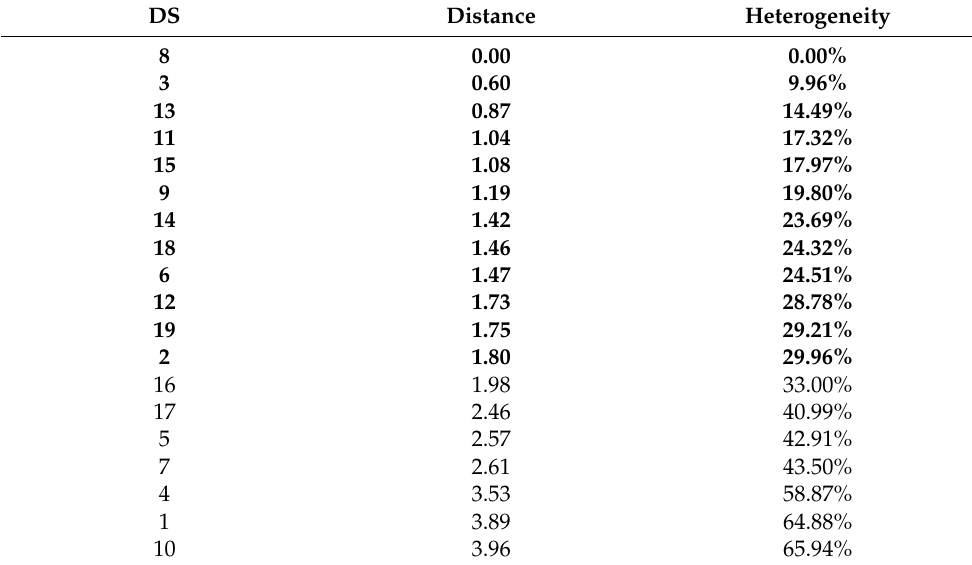
Table 6. Distance and heterogeneity between elements (reference DS